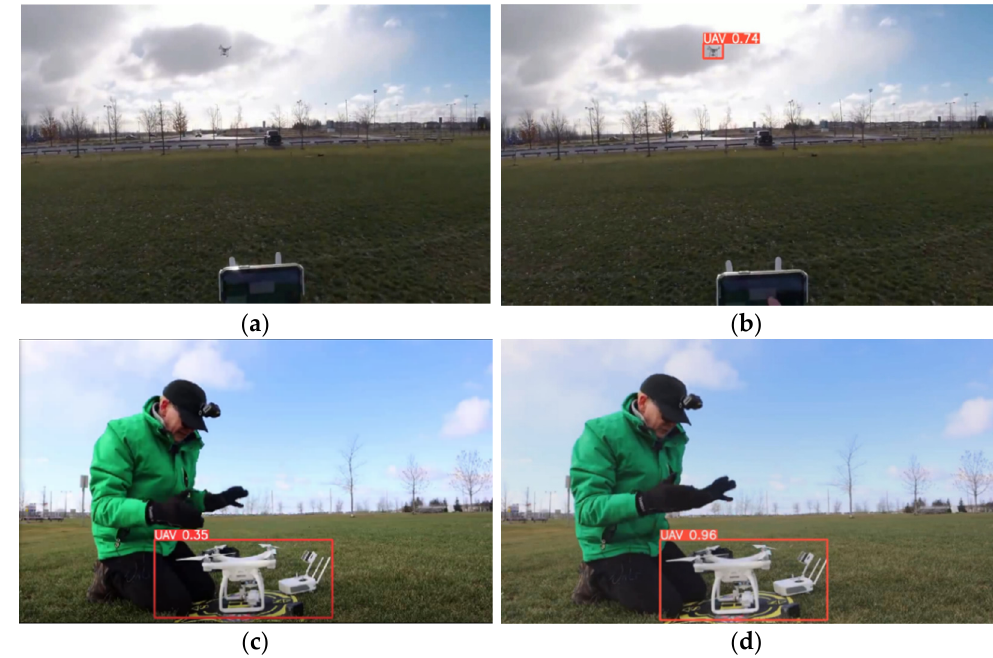
Figure 8. Comparison of network detection results before and after improvement (( a , c ) show the results using yolov5; ( b , d ) show the results using improved algorithm).